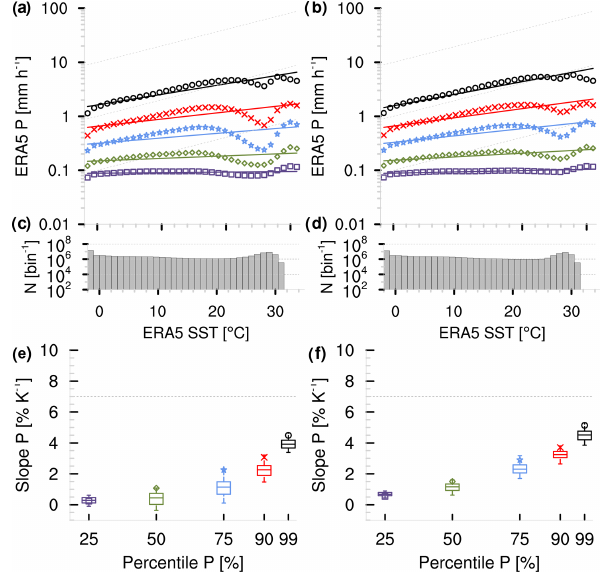
Figure A1. Panels (a) , (c) and (e) are the same as right panel of Fig. 2. Panels (b) , (d) and (f) exclude regions of r(P,ω 500 ) > − 0 . 2 from Fig. 3 for the complete ERA5